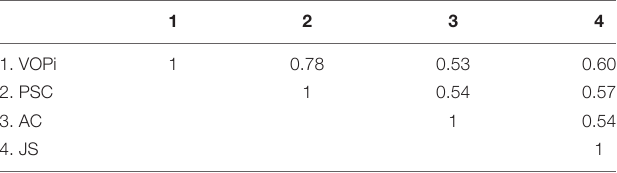
TABLE 6 | Convergent and predictive validity (Study